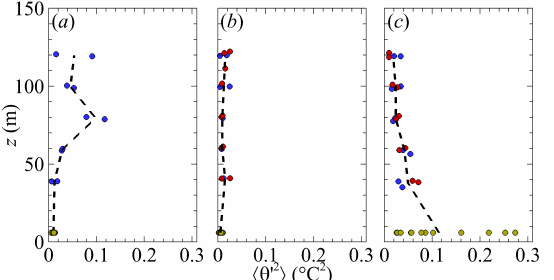
Figure 8. Vertical profiles of potential temperature variance measured during ( a ) flight 1, ( b ) flight 2, and ( c ) flight 3. The blue symbols indicate measurements made by BC5A, the red symbols indicate measurements made by BC5B and the olive symbols indicate measurements made by the sonic anemometer. The dashed line indicates the trend produced by averaging measurements at each